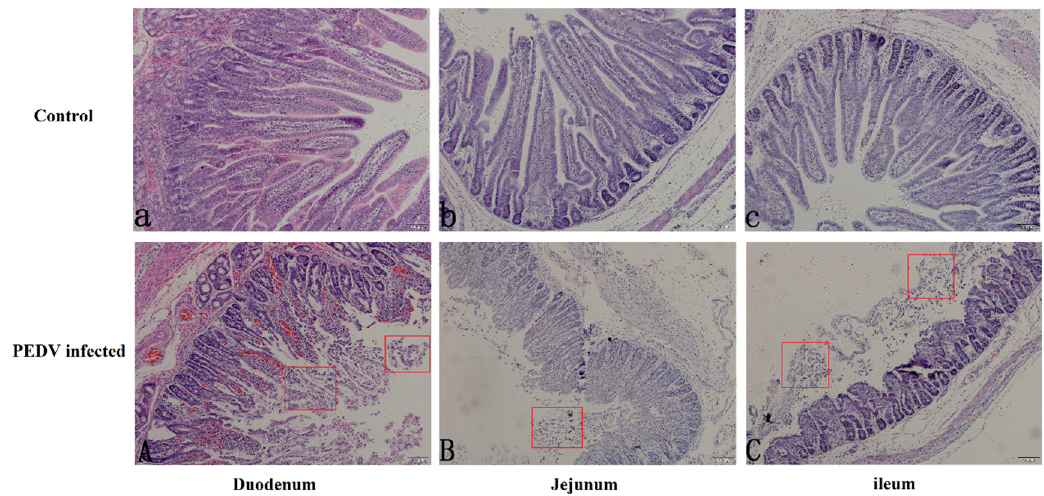
Figure 1. The para ffi n sections microscopy of three sections of the bowel in pig intestine (10 × ). The top group represents the duodenum ( a ), jejunum ( b ), and ileum ( c ) of normal piglets, and the bottom group represents the duodenum ( A ), jejunum ( B ), and ileum ( C ) of diarrheic piglets. The red square marks the area of intestinal villus loss.